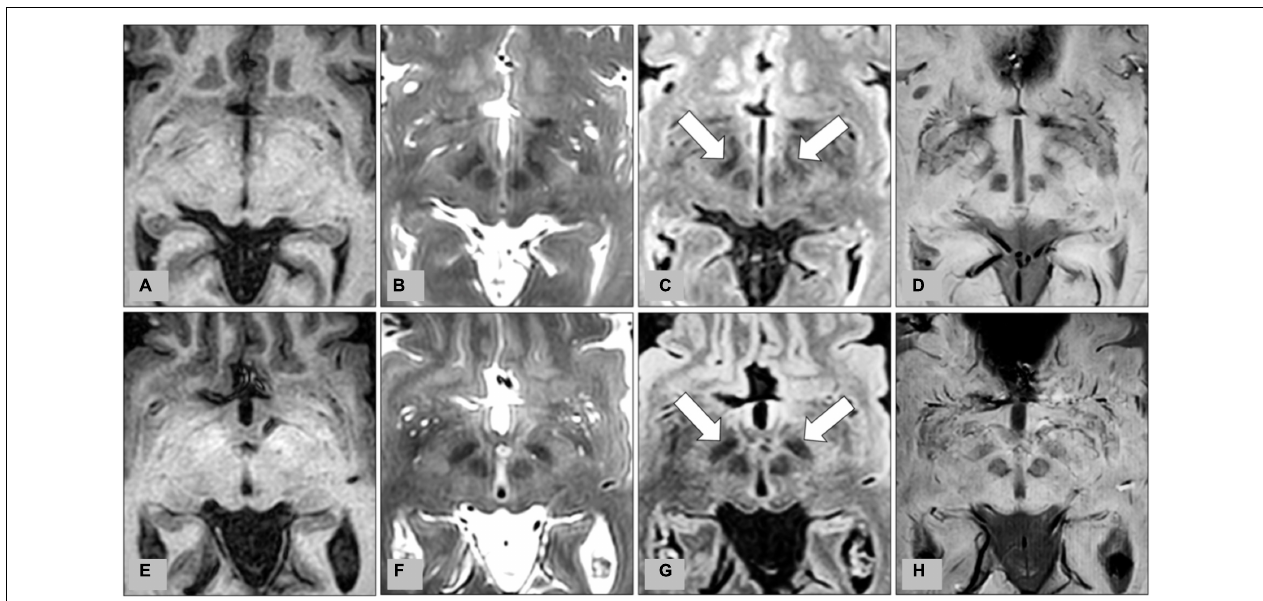
FIGURE 1 | Representative images from preoperative MRI of two patients with medication-refractory Parkinson’s disease at the level of the subthalamic nucleus (STN). (A) T1-weighted imaging (T1WI), (B) T2-weighted imaging (T2WI), (C) fluid-attenuated inversion recovery (FLAIR), and (D) susceptibility-weighted imaging (SWI) from MRI of a 56-year-old male patient, and corresponding (E) T1WI, (F) T2WI, (G) FLAIR, and (H) SWI from MRI of a 62-year-old male patient. Bilateral STN are indicated by arrows on FLAIR (C,G) .